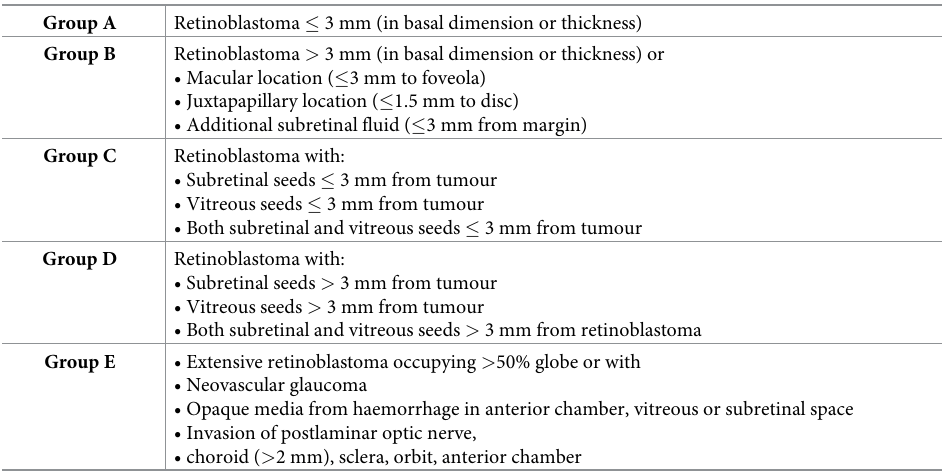
Table 1. Intraocular Classification of Retinoblastoma